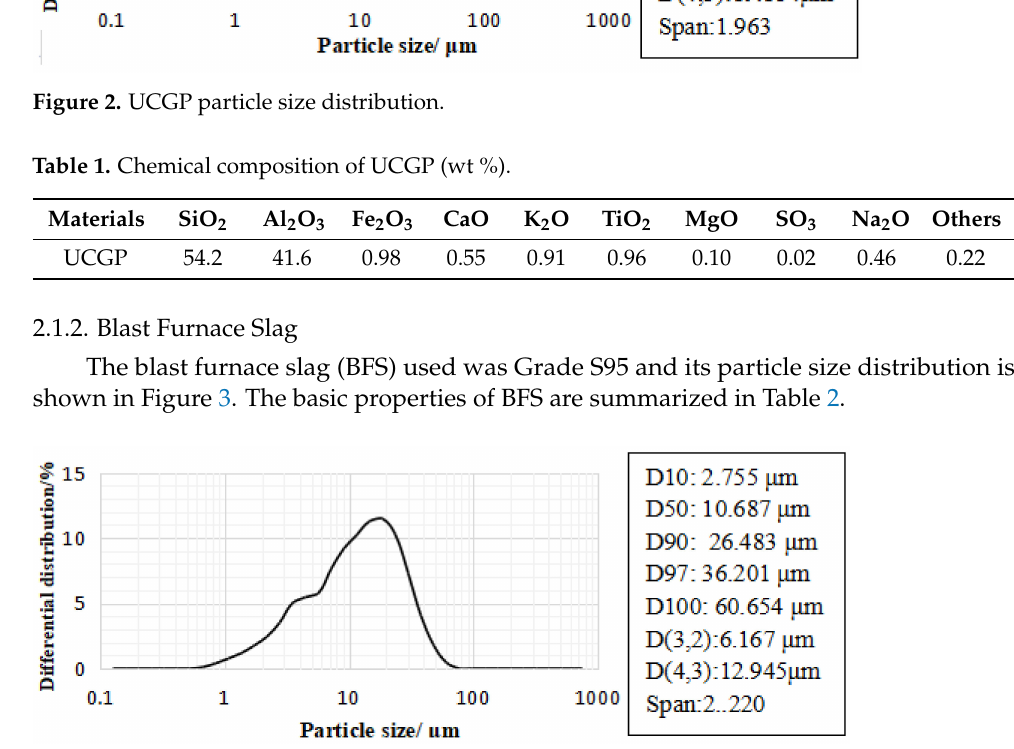
Figure 3. Particle size distribution of BFS. Table 2. Basic physical and chemical properties of BFS